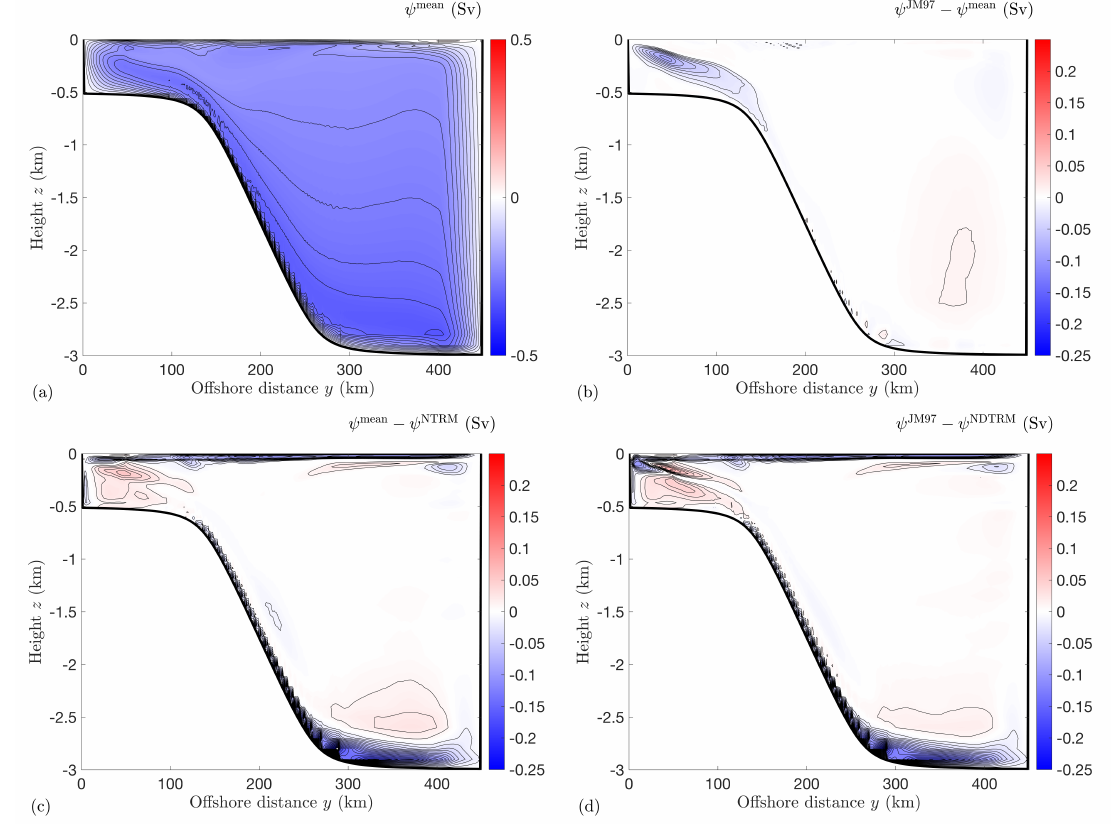
Figure 3. Comparison of transports calculated via TRM approximations vs. diagnosed directly from model output by averaging within density surfaces. Transports are quantified via streamfunctions with blue colors corresponding to counter-clockwise circulation and black contours shown at intervals of ( a ) 0.025Sv and ( b – d ) 0.01Sv. ( a ) Diagnosed transport within γ mean surfaces ( ψ mean ), ( b ) difference between diagnosed transports within γ JM97 surfaces and γ mean surfaces ( ψ mean − ψ JM97 ), ( c ) difference between NTRM-estimated transport within γ mean surfaces and diagnosed transport within γ mean surfaces ( ψ NTRM − ψ mean ), ( d ) difference between NDTRM-estimated transport within γ n surfaces and diagnosed transports within γ JM97 surfaces ( ψ JM97 − ψ NDTRM ). The diagnosed streamfunctions, ψ mean and ψ JM97 , have been mapped from density to z coordinates using the time-mean depths of γ mean and γ JM97 surfaces,